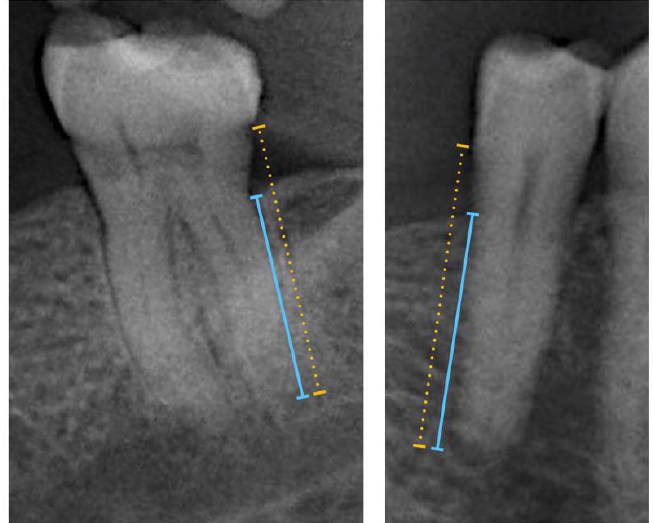
Figure 1. Radiographic-based Periodontal Bone Loss (R-PBL) was measured from the marginal alveolar bone to the tooth apex (blue line) and from the cementoenamel junction to the tooth apex (yellow dotted line), as in Rydén et al. [16] The examples show R-PBL measurement in a molar and premolar.